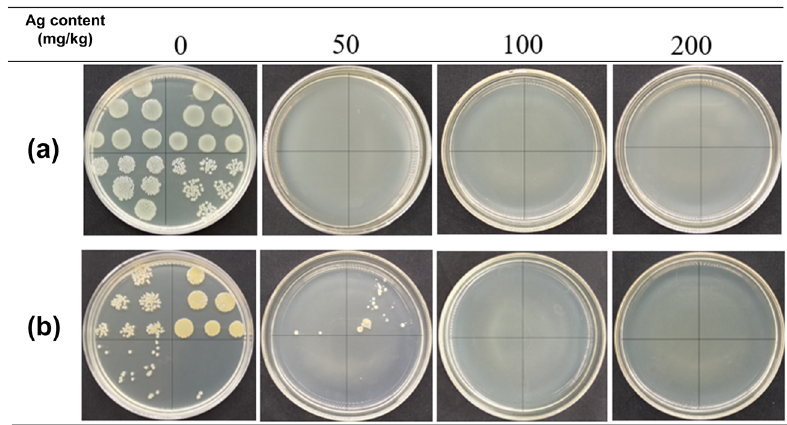
Figure 8: The antibacterial activity of AgNP - coated polyester fi bers against ( a ) Escherichia coli and ( b ) Staphylococcus aureus .